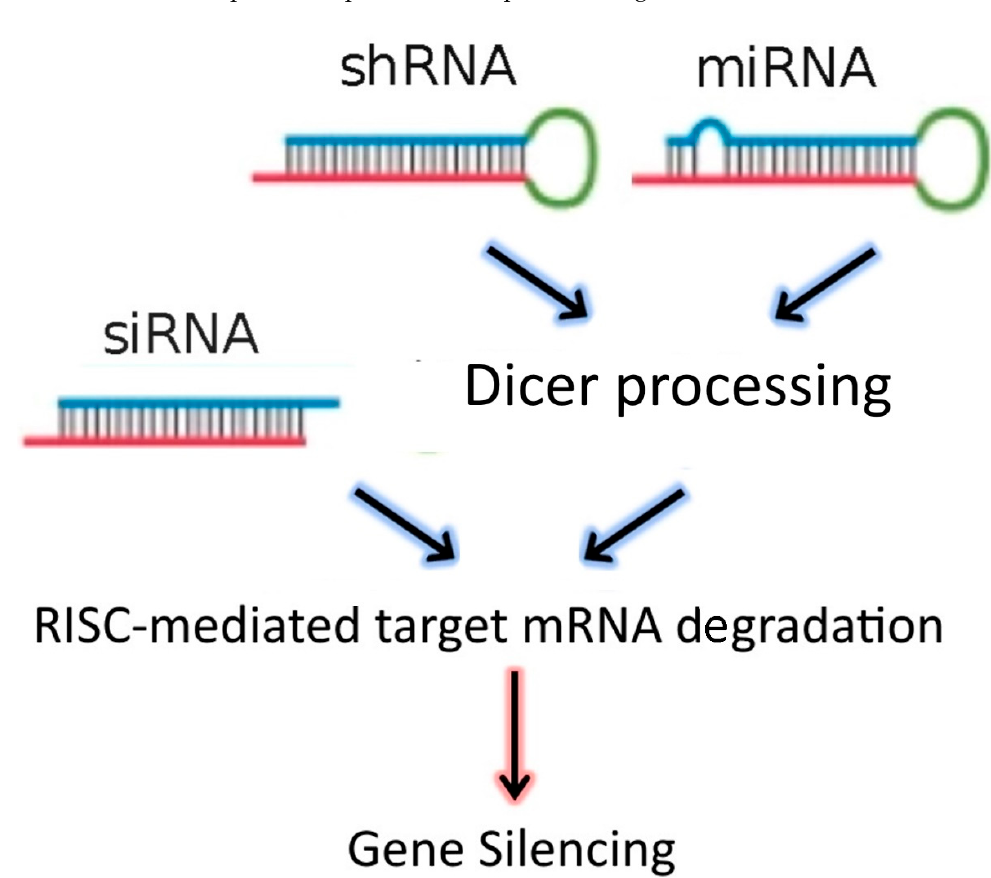
Figure 1. RNAi-based therapeutics for gene silencing.